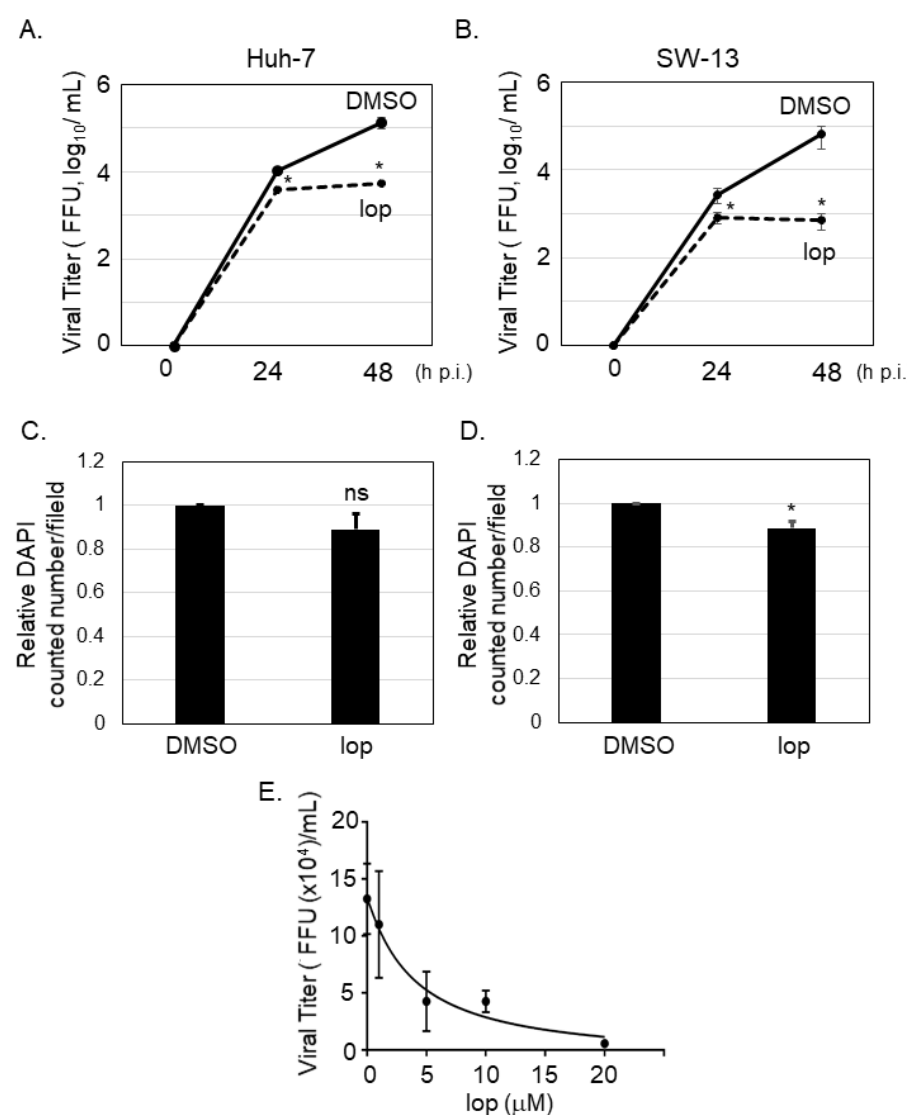
Figure 1. Loperamide treatment inhibited severe fever with thrombocytopenia syndrome virus (SFTSV) propagation. Huh-7 ( A ) or SW-13 ( B ) cells were infected with SFTSV (multiplicity of infection (MOI) = 0.1) and treated with loperamide (lop, 20 µ M). Culture supernatant was collected at 24 and 48 h post infection (h p.i.) to measure the virus titers using Vero 76 cells. ( C , D ) Infected cells were fixed with 4% paraformaldehyde (PFA) and stained with DAPI for counting the numbers of viable cells. Relative DAPI-positive cell numbers from Huh-7 cells at 24 h ( C ) and 48 h ( D ) post loperamide treatment, respectively. ( E ) 50% inhibitory concentration (IC 50 ) of loperamide against SFTSV in Huh-7 cells was calculated. Huh-7 cells were infected with SFTSV at an MOI = 0.1 and treated with 1, 5, 10, or 20 µ M of loperamide. At 48 h p.i., culture media was collected to measure SFTSV titer. IC 50 was calculated using GraphPad Prism 5. Data correspond to the mean ± SD (ns; not significant, * p < 0.05).